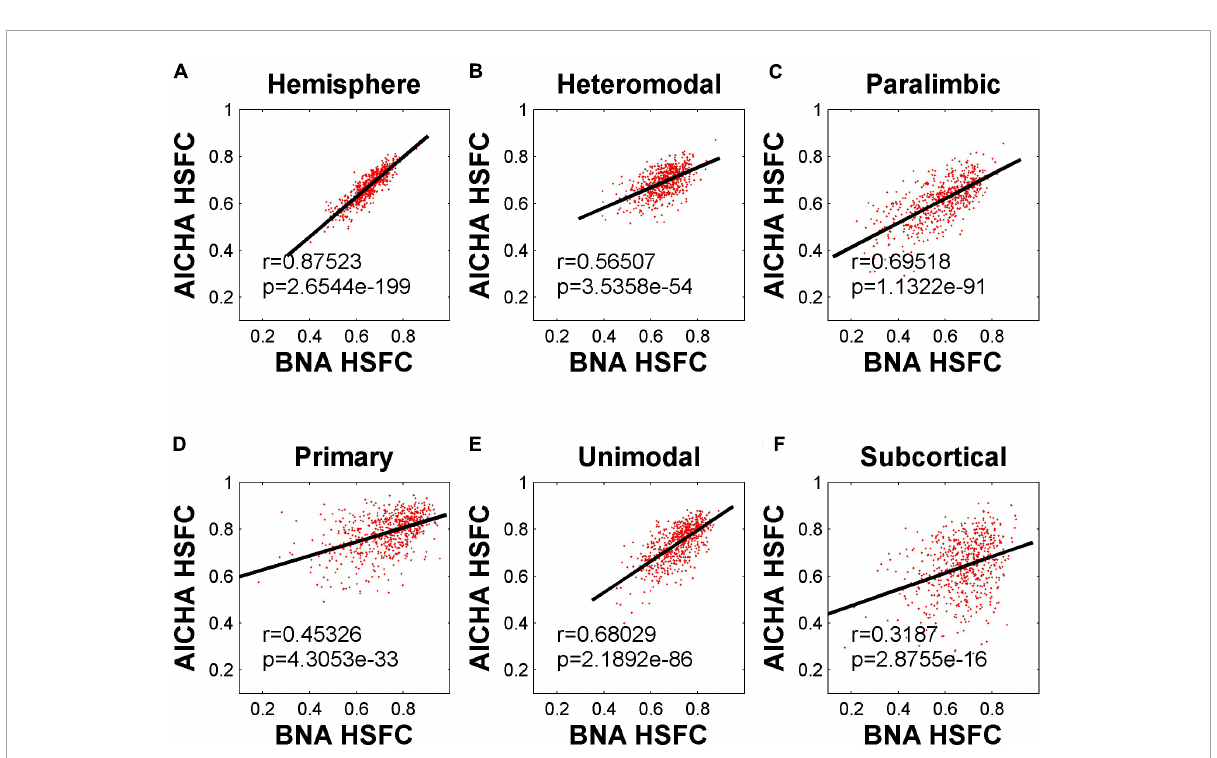
FIGURE5 Pearson correlation of HSFC of hemisphere and five sub-modules between BNA and AICHA. (A–F) Represent the hemisphere, heteromodal, paralimbic, primary, unimodal, subcortical,